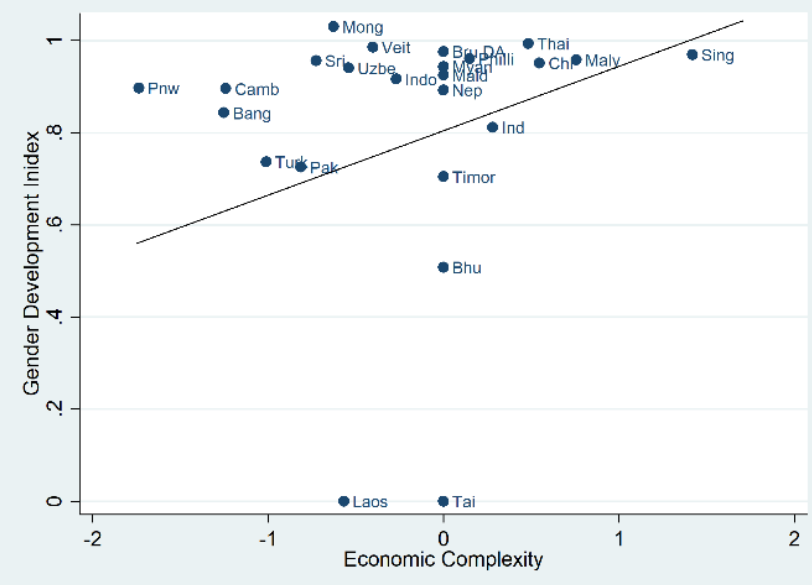
Figure 1. Gender Development Index and Economic Complexity.